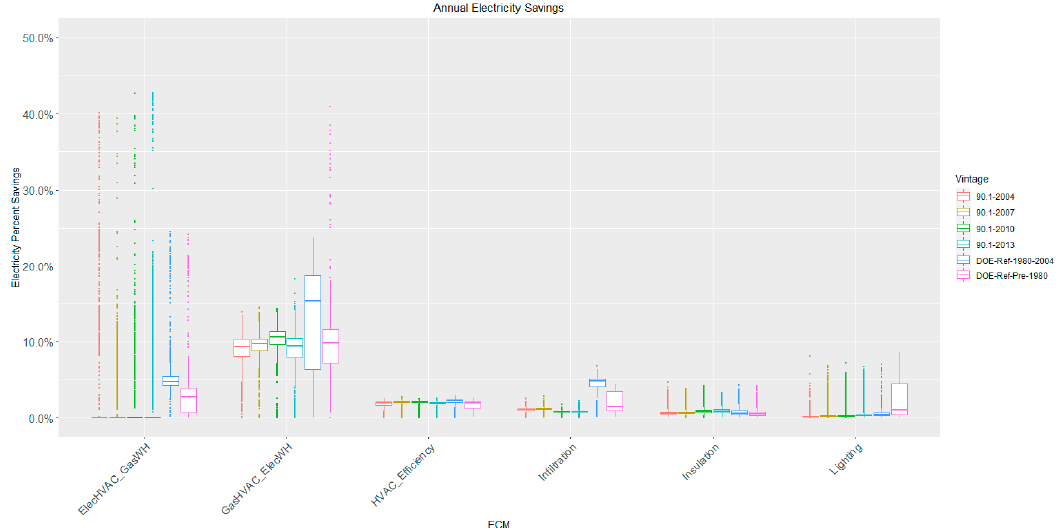
Figure 9. Distribution of potential annual electricity savings for two fuel-switching technologies (water heater and HVAC), and four traditional energy efficiency measures.